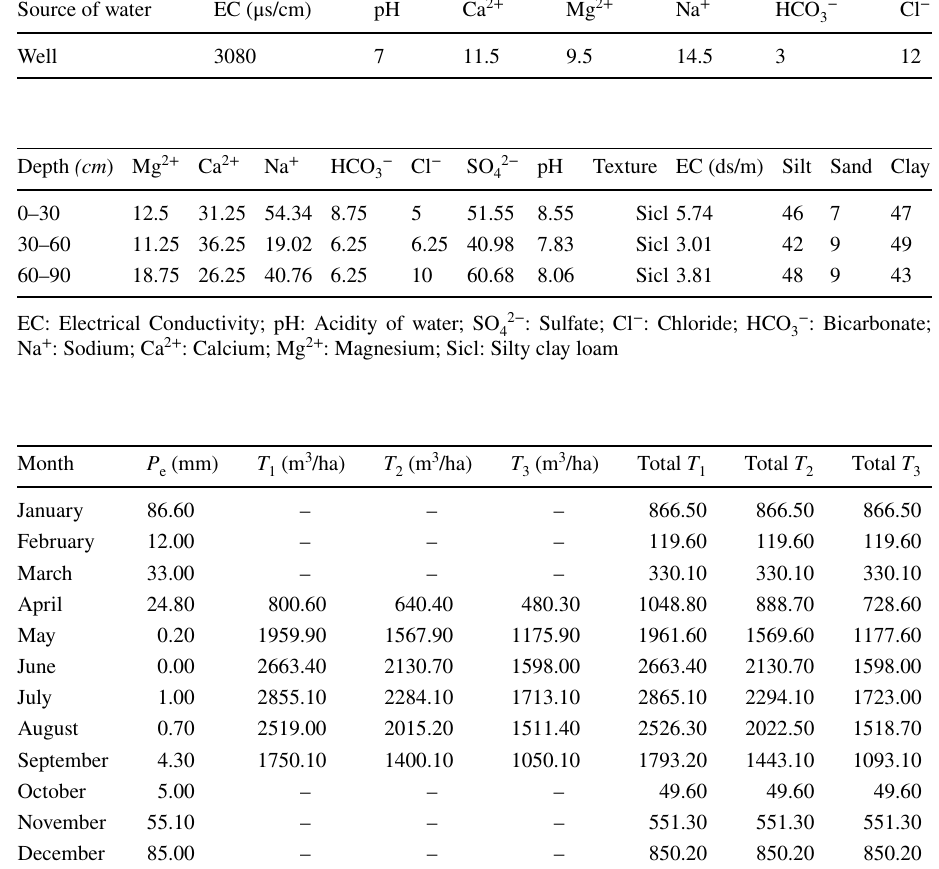
Table 3 Quality of the water used for irrigation